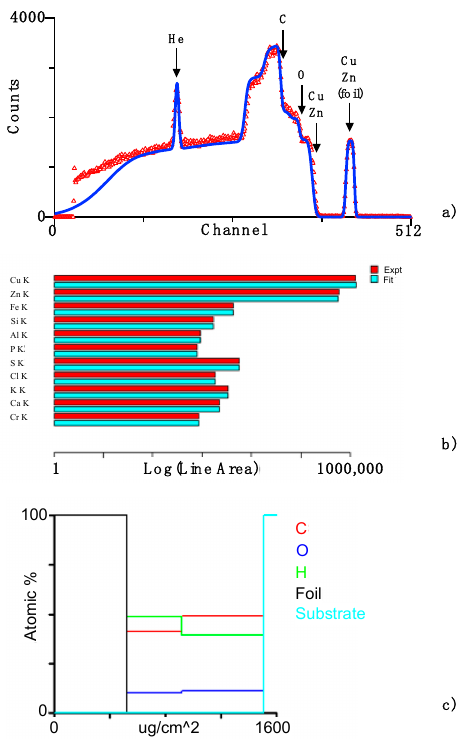
Figure 6. External beam IBA measurements of a presumed oil gilding on brass with 3 MeV protons. ( a ) Experimental (red symbols) and simulated (blue line) EBS spectra. ( b ) Comparison of experimental (red) and fitted (light blue) X-ray peak areas from PIXE, for main and trace elements. ( c ) Fitted structure of the sample showing the elemental depth distribution.